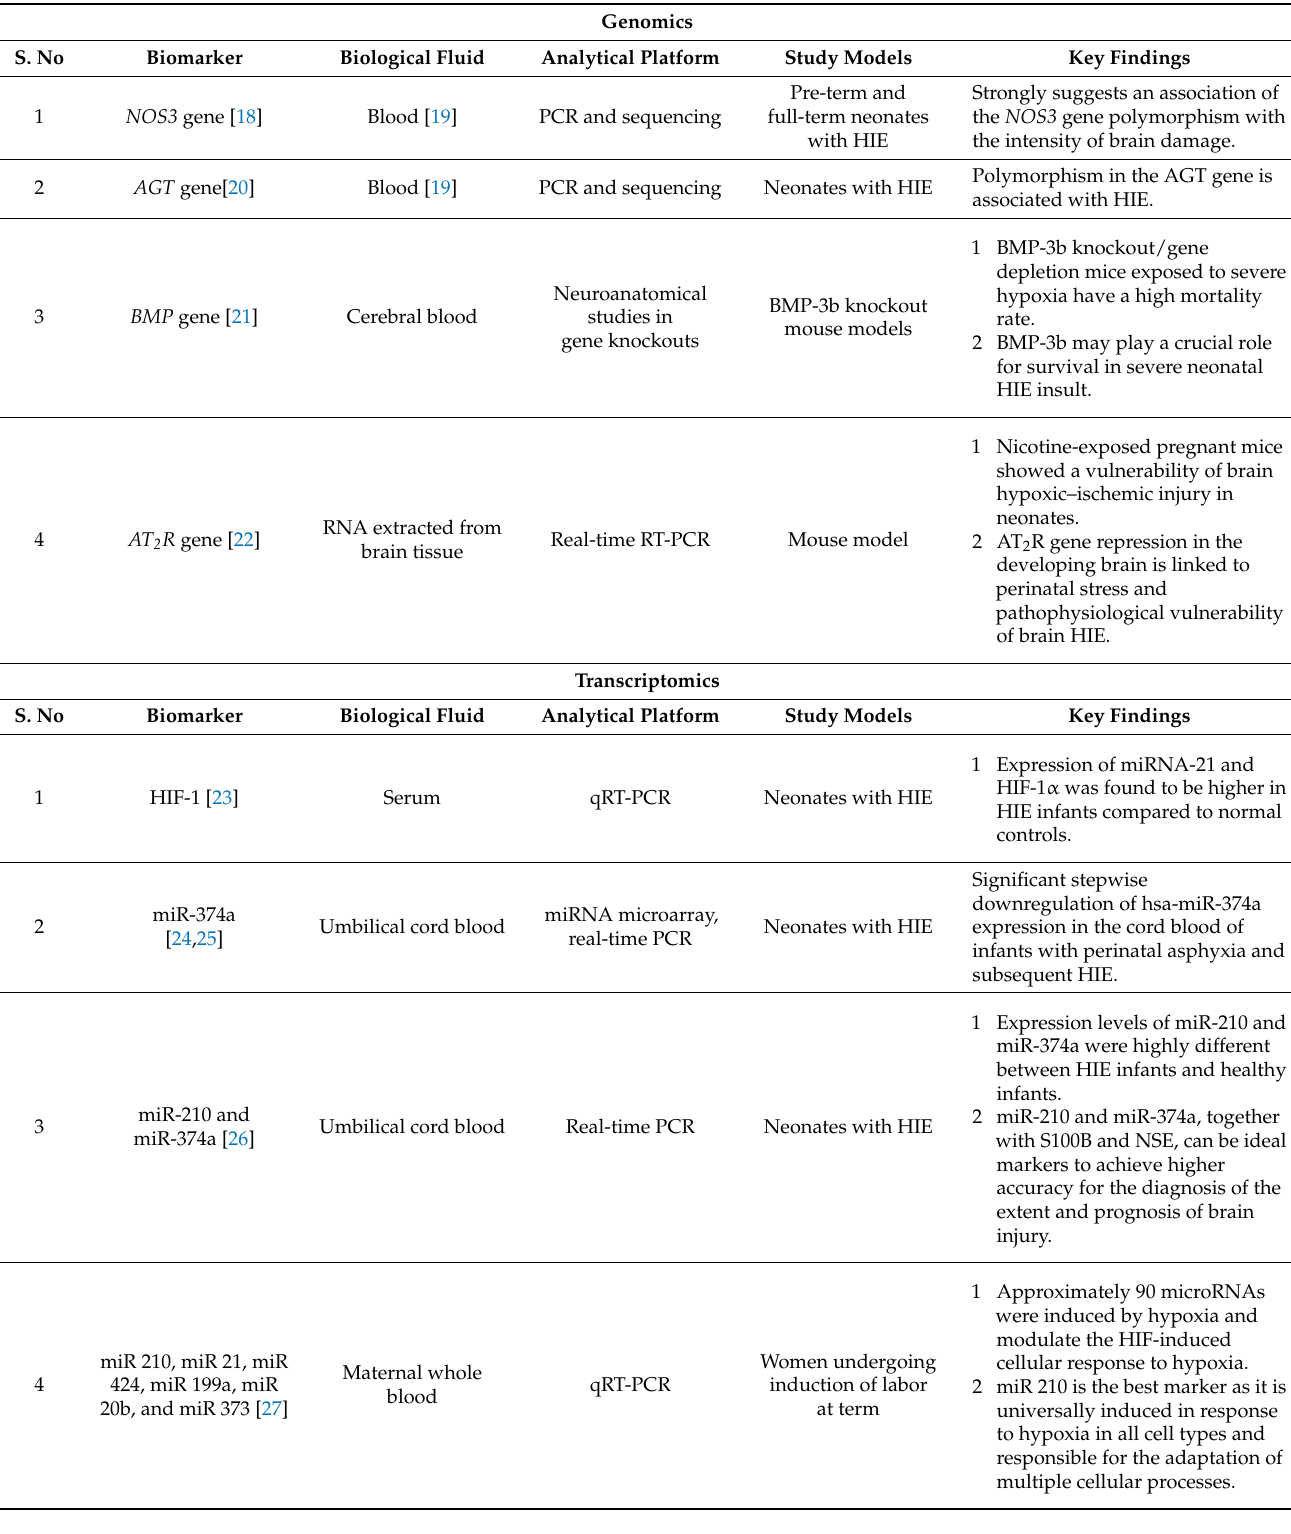
Table 1. Various genomics and transcriptomes in